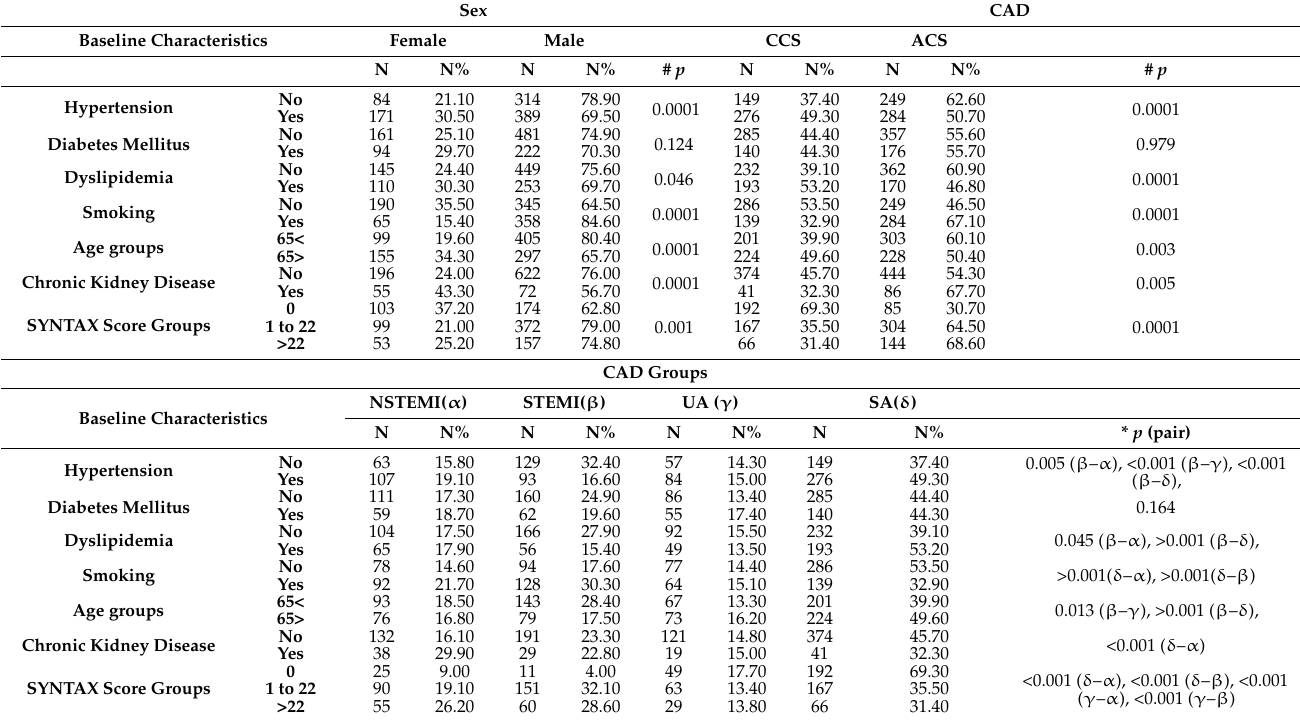
Table 1. Baseline clinical and demographic characteristics of the studied